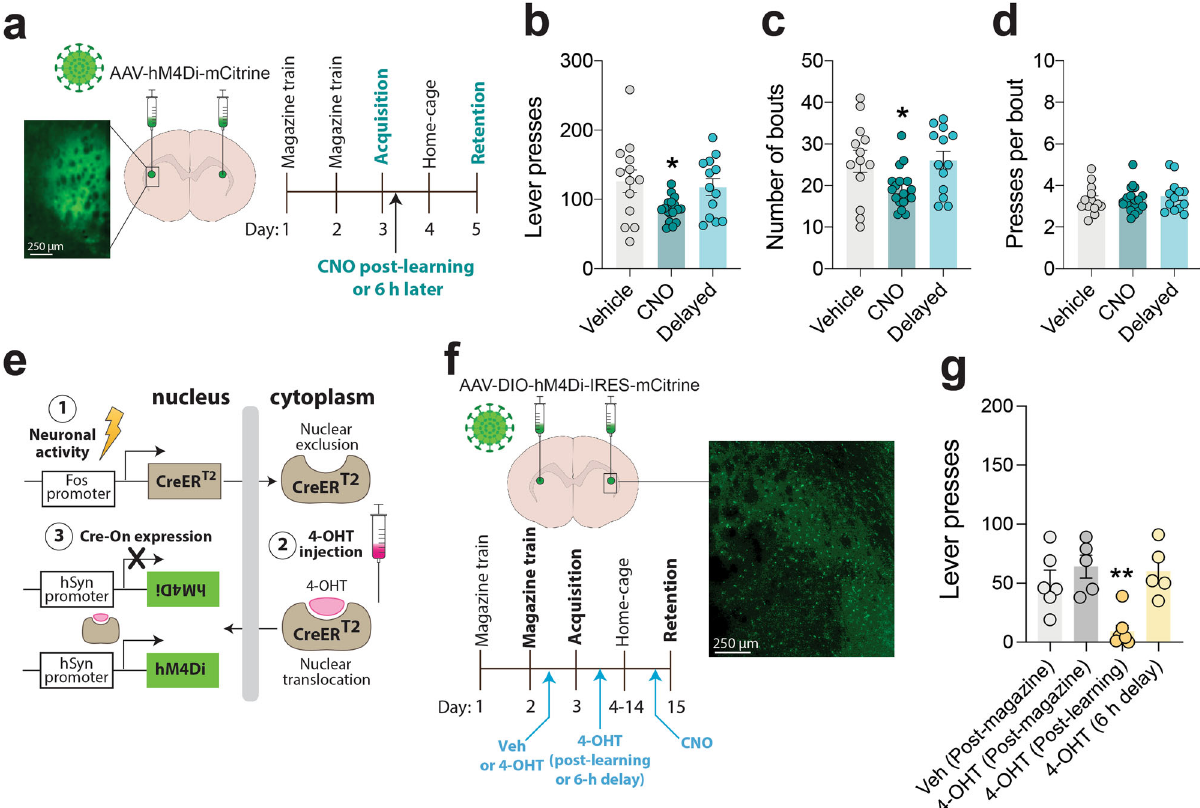
Fig. 3 aDLS activity regulates consolidation of new learning. a Graphical representation of inhibitory hM4Di-mCitrine DREADD virus delivered to aDLS of mice, experimental design, and representative mCitrine image from aDLS-injected mouse. b Mean (±s.e.m.) number of lever presses in vehicle-treated mice ( n = 13), mice injected with CNO after new learning ( n = 18), and mice injected with CNO 6 h after new learning ( n = 13); F (2,42) = 4.346, p = 0.0194, One-way ANOVA; * P = 0.0247 compared with vehicle-treated mice, post-hoc test. c , Mean (±s.e.m.) number of bouts of lever presses; F (2,41) = 4.536, p = 0.0166; * P = 0.0434 compared with vehicle-treated rats, post-hoc test. d Mean (±s.e.m.) number of lever presses per bout; F (2,41) = 0.2868, p = 0.7522. e Graphical representation of c-Fos-stimulated CreER T2 transcription (1), 4-OHT-mediated nuclear translocation of CreER T2 (2), and CreER T2 - mediated gene expression (3). f Graphical representation of inhibitory Cre-dependent DIO-hM4Di-mCherry DREADD virus delivered to aDLS of Fos- CreER T2 mice, experimental design, and representative image of mCitrine expression in aDLS of Fos-CreER T2 mice. Fos-CreER T2 mice were injected with vehicle (Veh; n = 6) or 4-OHT ( n = 5) after magazine training or injected with 4-OHT immediately ( n = 7) or 6 h ( n = 5) after the acquisition session. g Mean (±s.e.m.) number of lever presses in the four groups of CNO-treated Fos 2A-iCreERT2 mice during the retention test; F (3, 19) = 9.56, p = 0.0005; ** P < 0.01, compared with mice treated with vehicle after magazine training, post-hoc